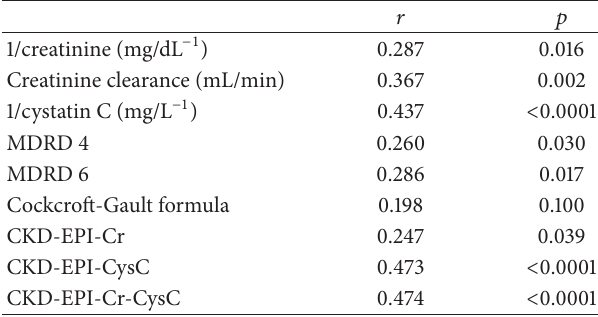
Table4:Pearson’scorrelationofthevariableswiththeisotopicGFR.